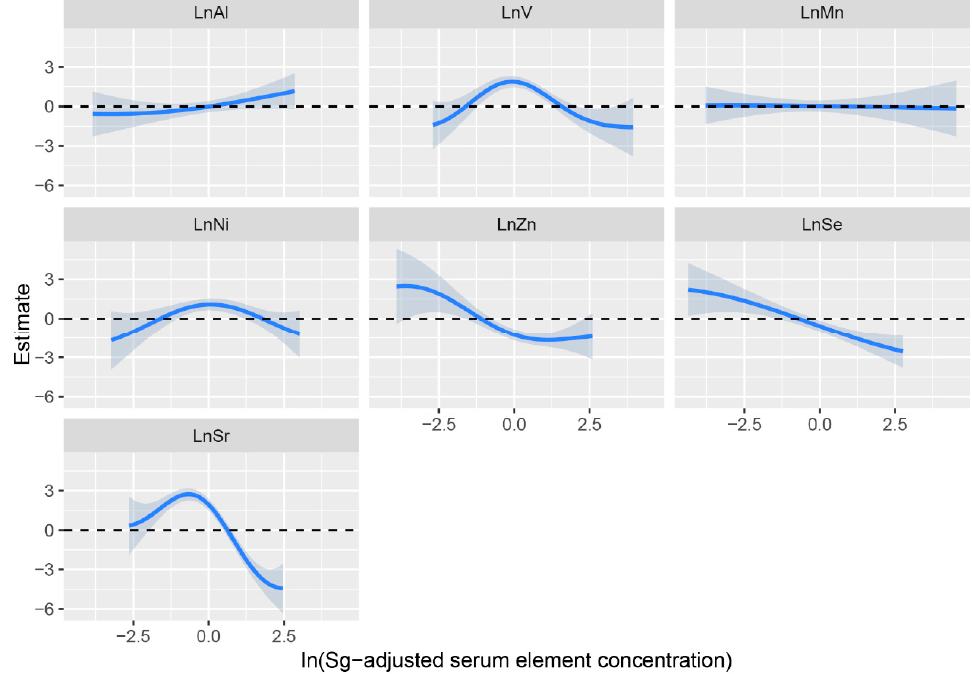
Figure 2. Univariate exposure–response relationship of serum Al, V, Mn, Ni, Zn, Se and Sr concentrations. The model was adjusted for smoking, drinking and family history of esophageal cancer, and other elements were fixed at their median.